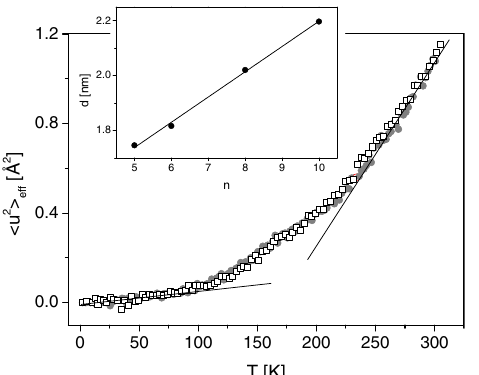
Figure 5. Temperature dependence of the effective mean square displacement < u 2 > eff for HAT5 (open squares) and HAT6 (filled circles) at lower temperatures in the plastic crystalline phase. The inset gives the core-core distance in the hexagonal ordered liquid crystalline phase of HATn versus the number of carbon atoms in the side chain according to [8].